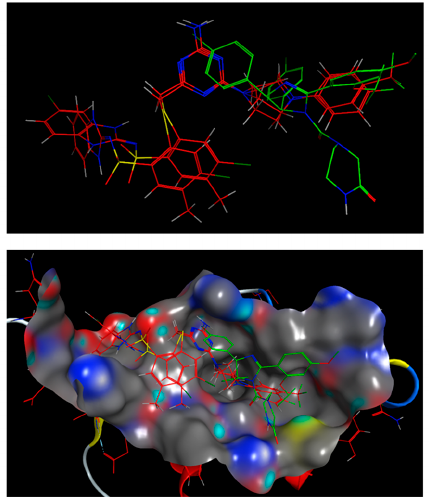
Figure 6. Superimposed representation of the compounds 22 , 46 and Nutlin-3a (green) in the active site of MDM2. Atoms other than carbon: sulfur – yellow, nitrogen – violet, oxygen – red, hydrogen – grey. Table 3. Docking results of the most active compounds 22 , 46 with MDM2 protein (PDB ID:5C5A).